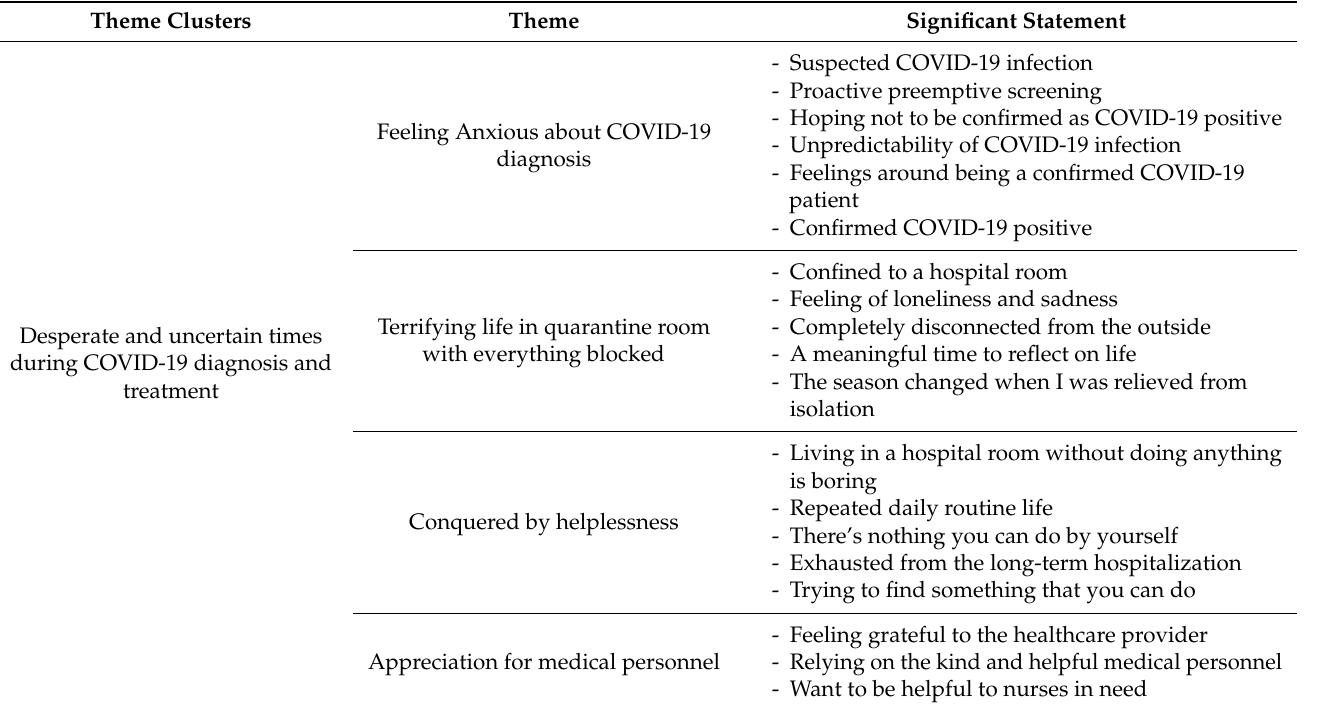
Table 2. COVID-19 patients’ physical and psychological